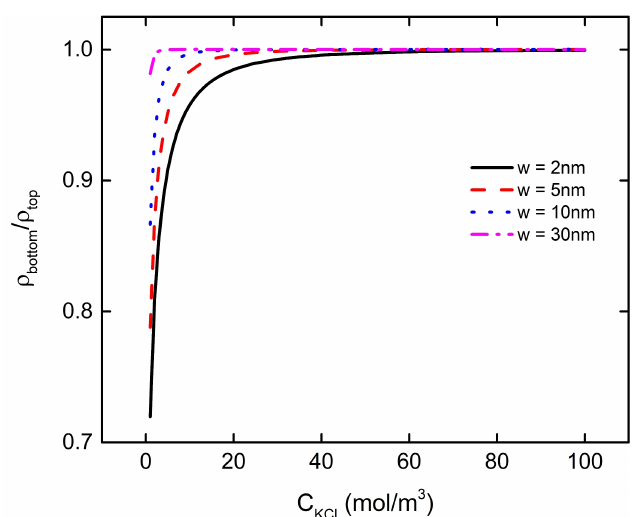
Figure 8. The ratio of bulk charge density of the PE brush layer at the bottom and top of the particle as a function of C KCl under di ff erent distances between particle and plate at pH = 7.